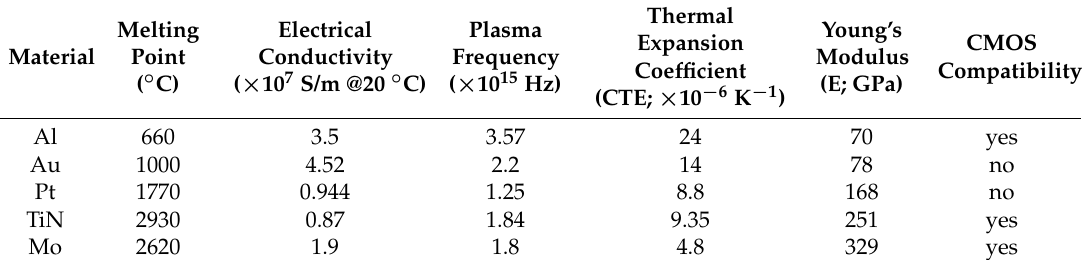
Table 1. Properties of metals used in MIM-PMAs. Adapted with permission from Reference [43]. © 2017 American Chemical Society. (CMOS: complementary metal oxide semiconductor).